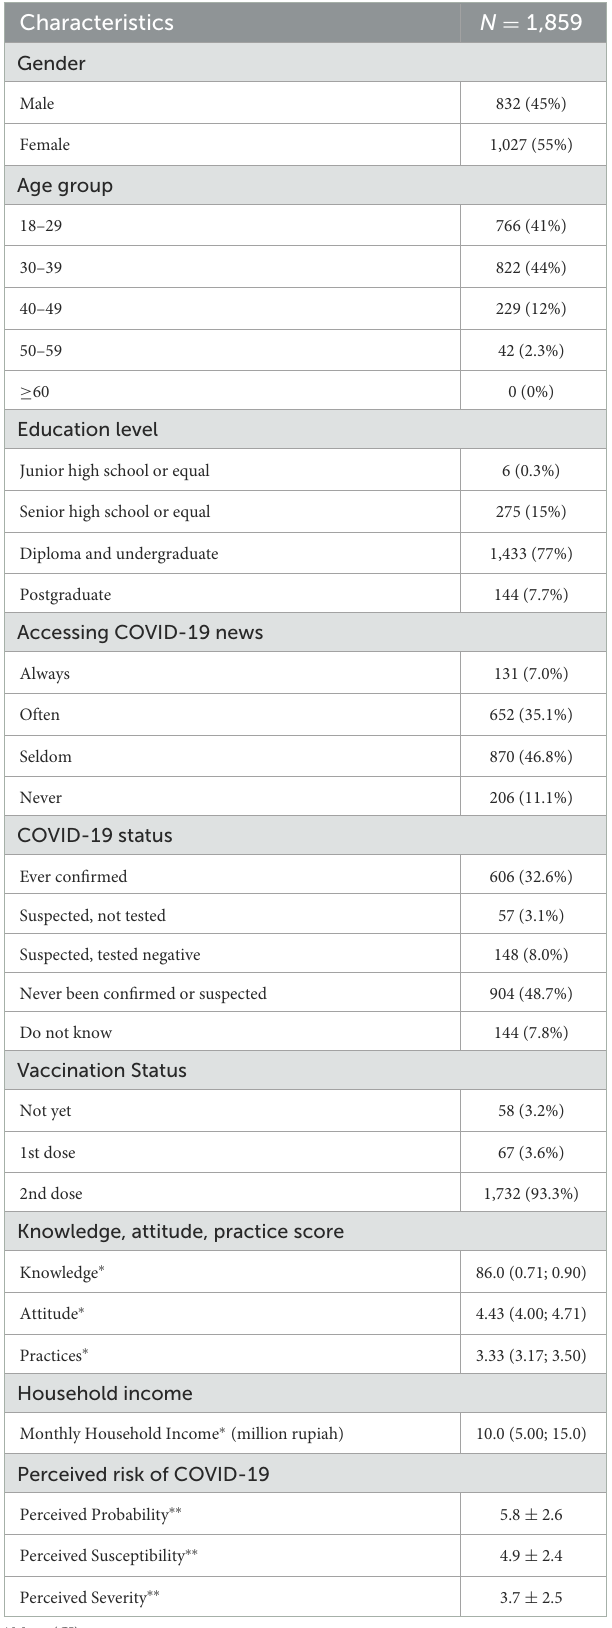
TABLE 1 Social and demographic characteristics of participants.